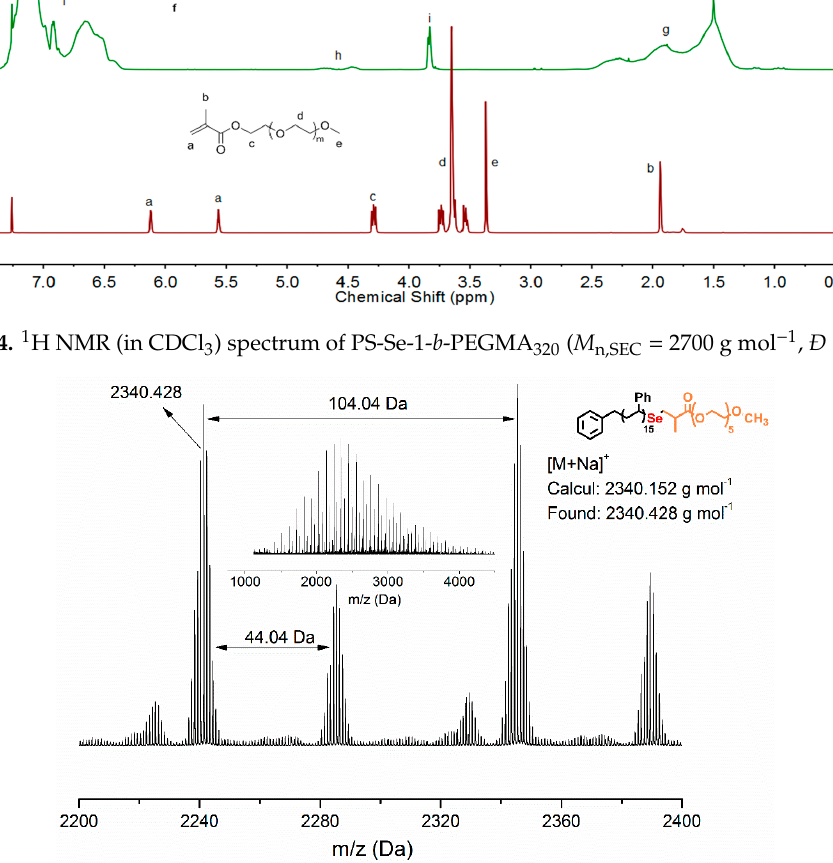
Figure 5. Mass spectra of PS-Se-1- b -PEGMA 320 ( M n,SEC = 2700 g mol − 1 , Ð = 1.09). Table 3. Selenol-based nucleophilic reaction of PS-Se with different molecular weight PEGMAs.